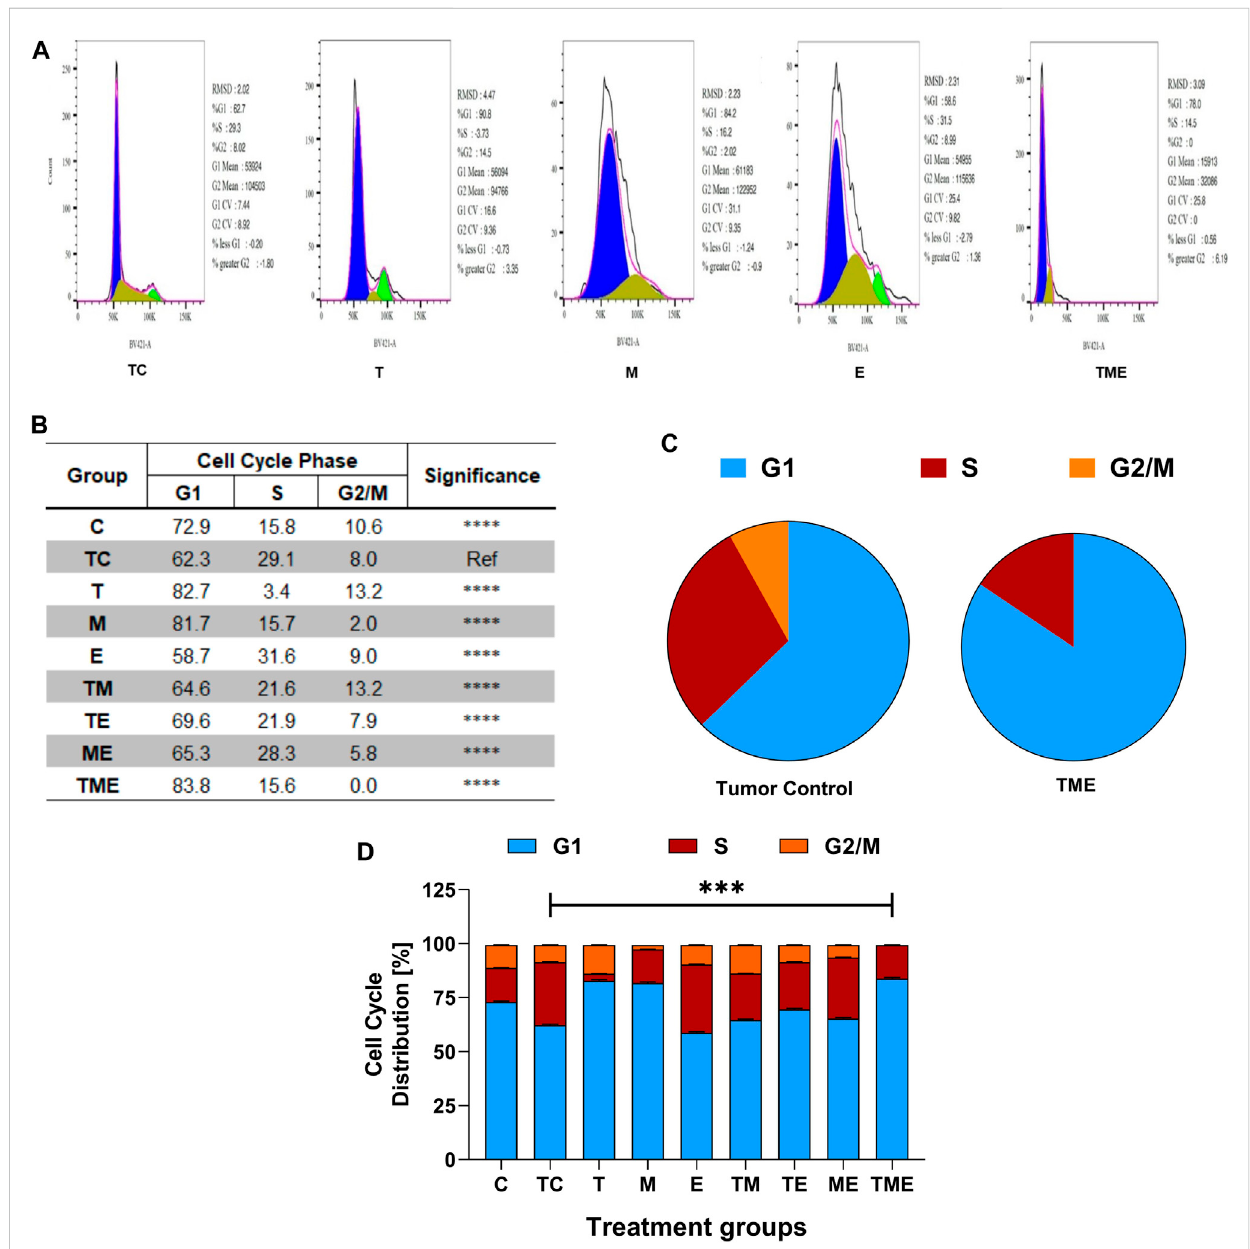
FIGURE 4 FlowCytometricanalysis. (A) Effectofthedrugs,individuallyandincombinationoncellcycle,whereinthehistogramsrepresenttheDNAcontentof the cells in each of the cell cycle phases (G0/G1, S and G2/M). Different cell cycle phases were plotted (B) Percentage of total events, wherein the bar- graph depicting the percentage of cells in G1, S and G2/M phases in each treatment group. (C) Pie chart representing the percentage of cells in G1, S and G2/M phases in tumor-control and triple-drug treatment group respectively. (D) Tabulation of percentage of cell in different phases in each treatment group. All the experiments were performed in triplicates, the data represented are as mean ± standard deviation and the signi fi cance was calculated using two-way ANOVA (*** P <